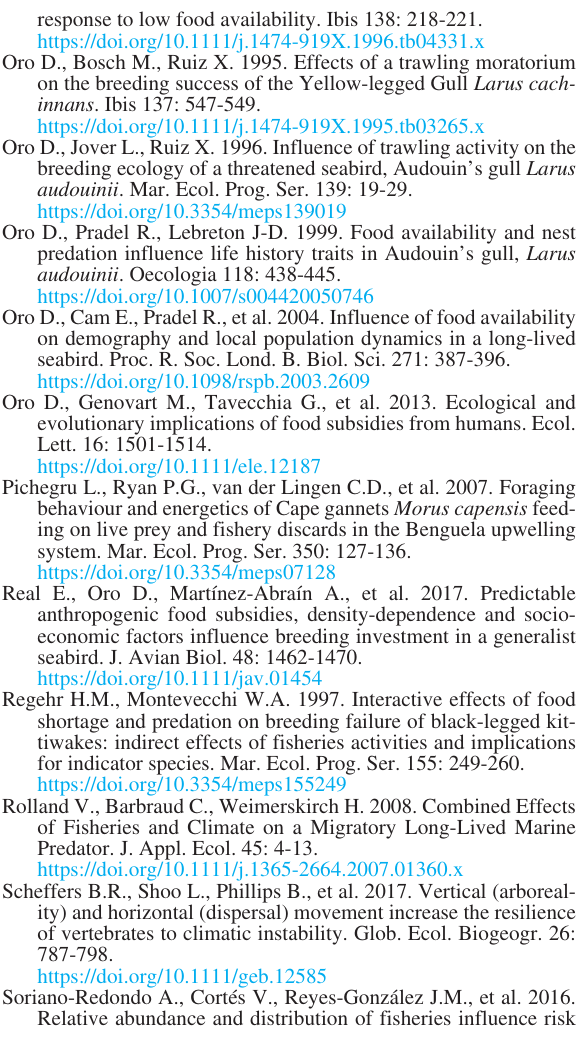
Table S1. – Seabird species identified as scavengers of fishery discards according to reviewed studies and number of studies considering each ecological effect derived from seabird-discard